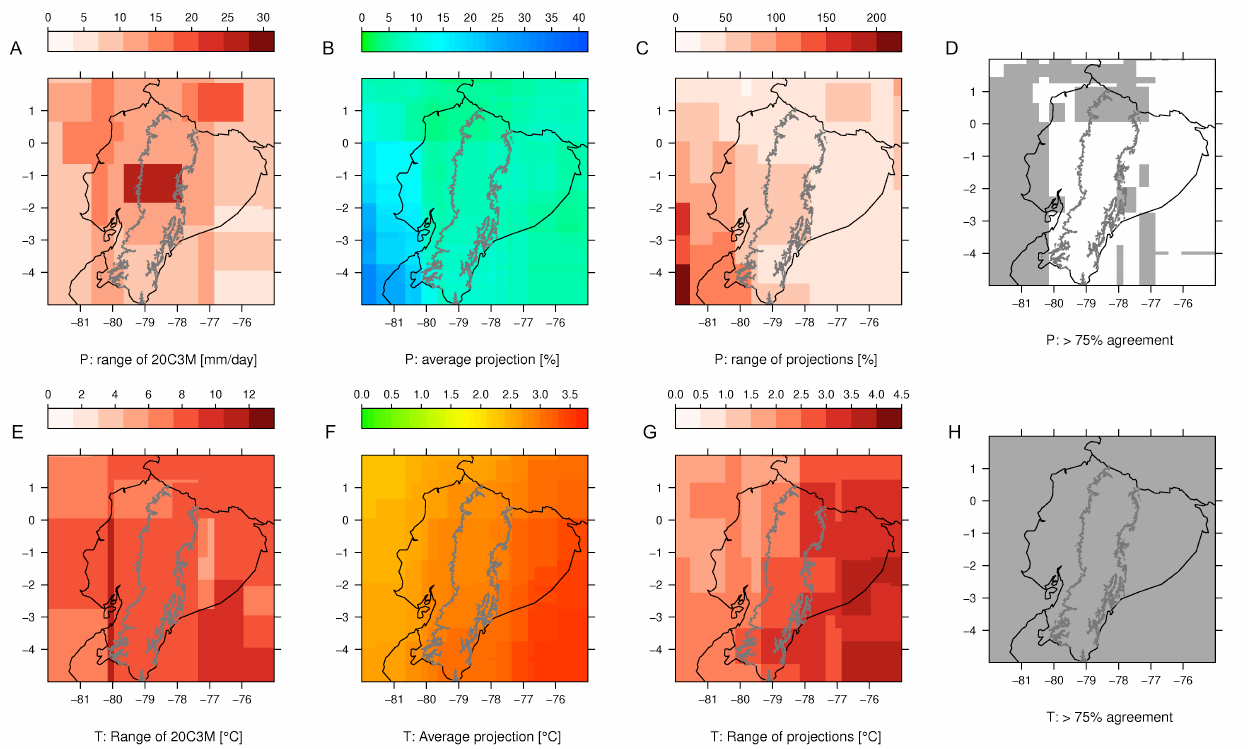
Fig. 2. Average, range and consistency of the GCM simulations of yearly temperature ( T ) and precipitation ( P ) in the Ecuadorian An- des. A and E : range of the projections for the twentieth century run (20C3M) during 1961–1990; B and F : average and C and G : range of the projected anomalies for the A1B emission scenario (in % for P , ◦ C for T ) from 20C3M to the scenario period 2070–2099; D and H : regions where more than 75% of the models agree on the direction of the change (in grey). The models used in the GCM ensem- ble are: BCCR-BCM2, CCCMA-CGCM3.1-T47, CCCMA-CGCM3.1-T63, CNRM-CM3, CONS-ECHO-G, CSIRO-MK3, GFDL-CM2, GFDL-CM2.1, INM-CM3, IPSL-CM4, LASG-FGOALS-G1.0, MPIM-ECHAM5, MRI-CGCM2.3.2, NASA-GISS-AOM, NASA-GISS- EH, NCAR-CCSM3, NIES-MIROC3.2-HI, NIES-MIROC3.2-MED, UKMO-HADCM3, UKMO-HADGEM1. All models were rescaled to a common resolution of 0.1 ◦ before averaging. The 1000m contour line of the Ecuadorian Andes is indicated in